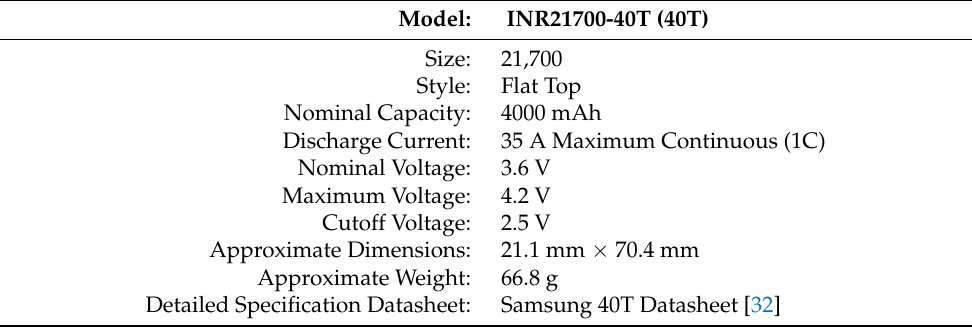
Table 1. Parameters of the cell used for